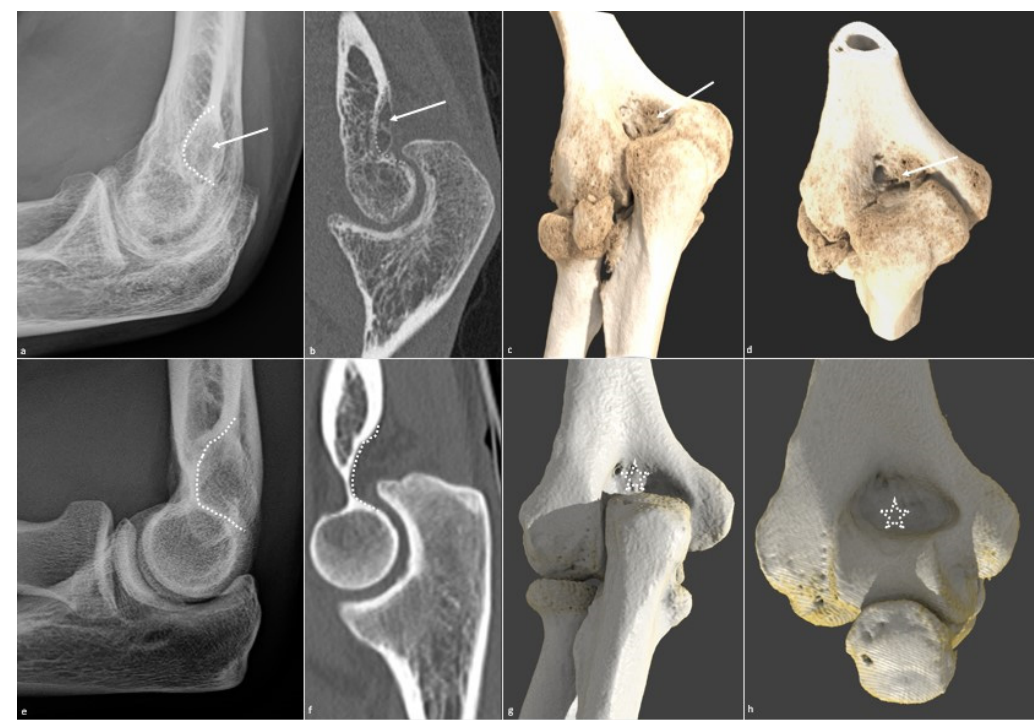
Figure 5. Loss of extension secondary to a bony osteophytic impingement. A bone block secondary to a trochlear osteo- phyte (white arrow) in a 51-year-old man, manual worker, is shown on ( a ) a profile view radiograph (not depicted), ( b ) a sagittal CT-scan reformat, and ( c ) a global illumination 3D reformat.